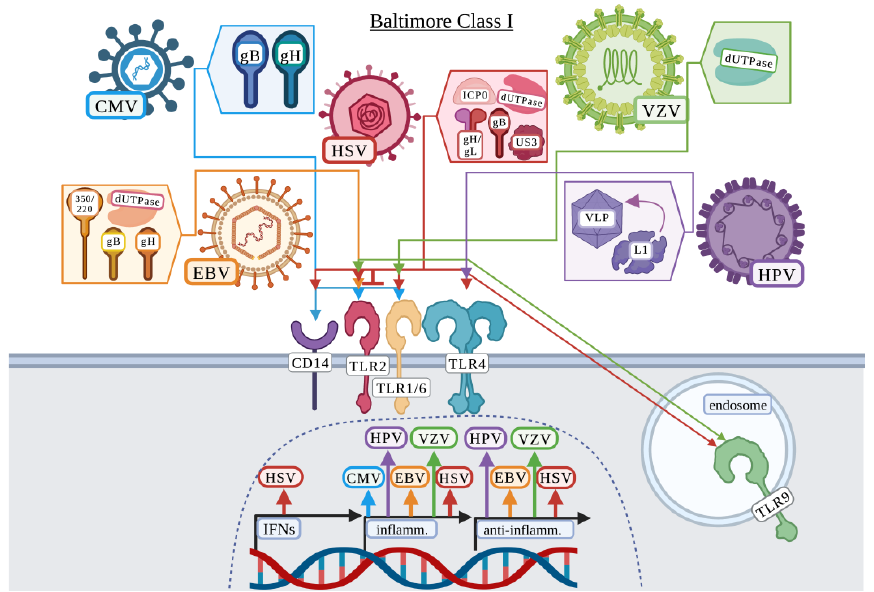
Figure 2. Baltimore Classification I viruses recognized by surface Toll-like Receptors (TLRs): within Bal- timore Class I, 5 viruses were identified as activating a surface TLR response including